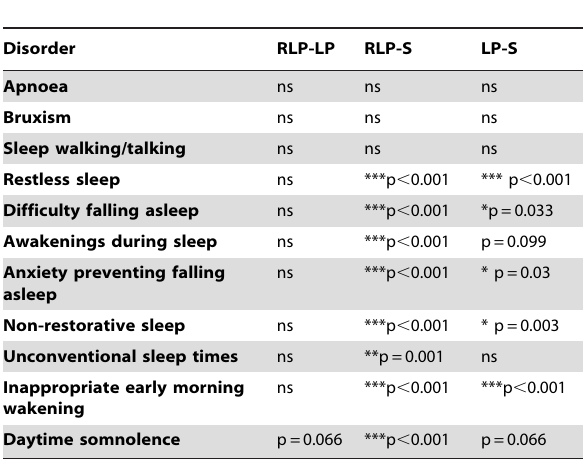
Table 4. Statistically significant differences in the rates of self- reported sleep disturbances across the three subject groups.